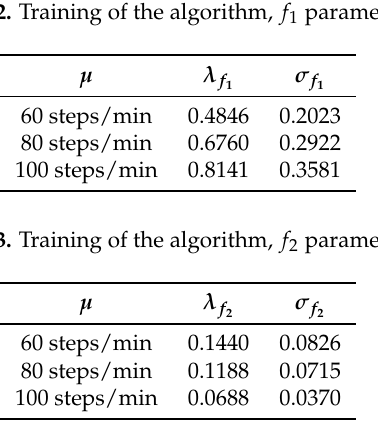
Table 2. Training of the algorithm, f 1 parameters.